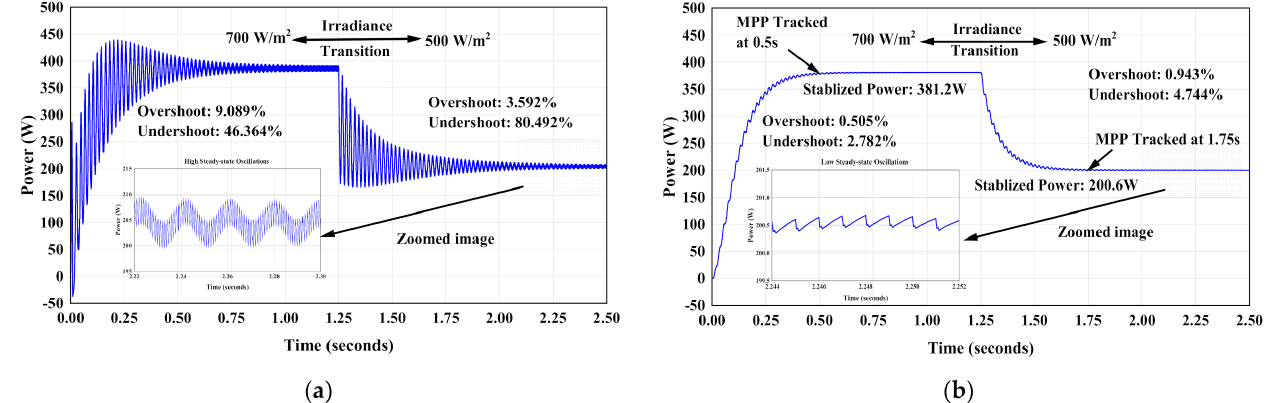
Figure 12. Power characteristics during irradiance transition (UI-1 → UI-2): ( a ) high oscillations, ( b ) low